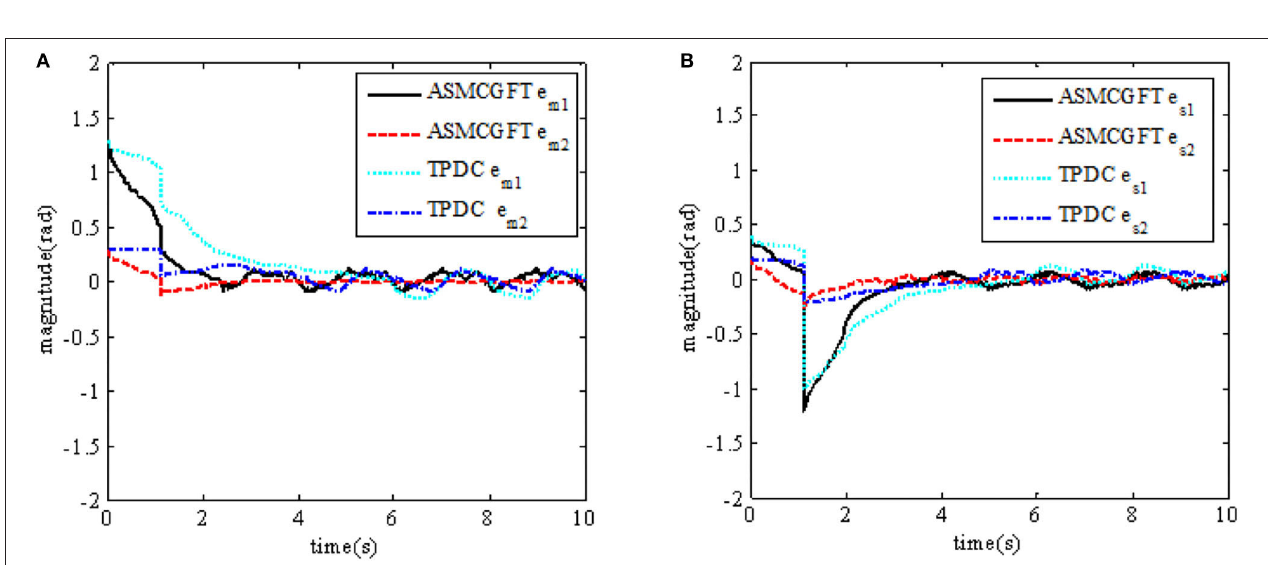
FIGURE 5 | Comparison of tracking error between master and slave robots. (A) Comparison of the master robot’s joint position tracking error (B) Comparison of the slave robot’s joint position tracking error.